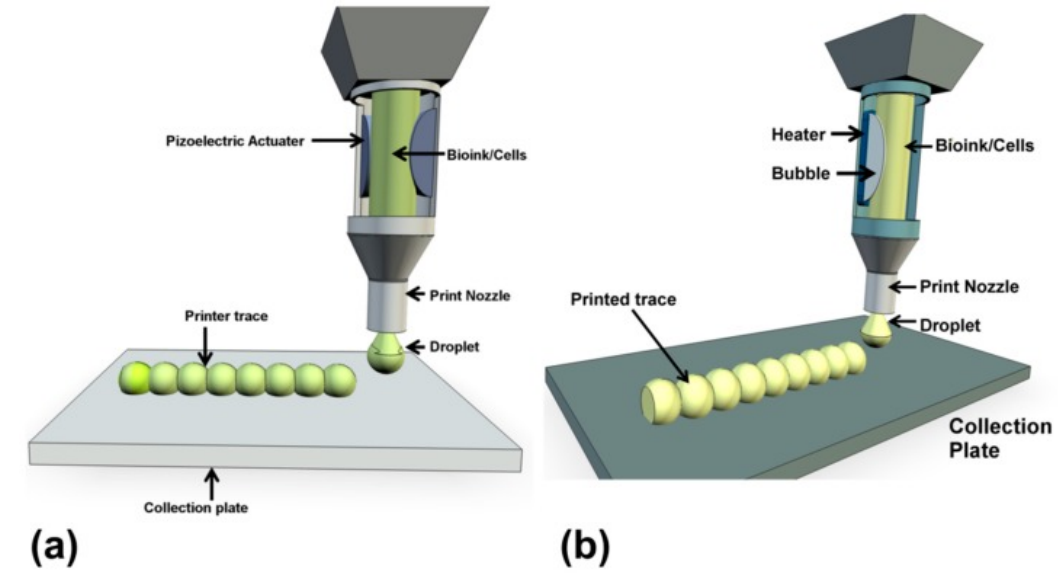
Figure 2. A representation of inkjet bioprinting of droplets onto collection plates with a piezoelectric actuator ( a ) and a thermal actuator ( b )